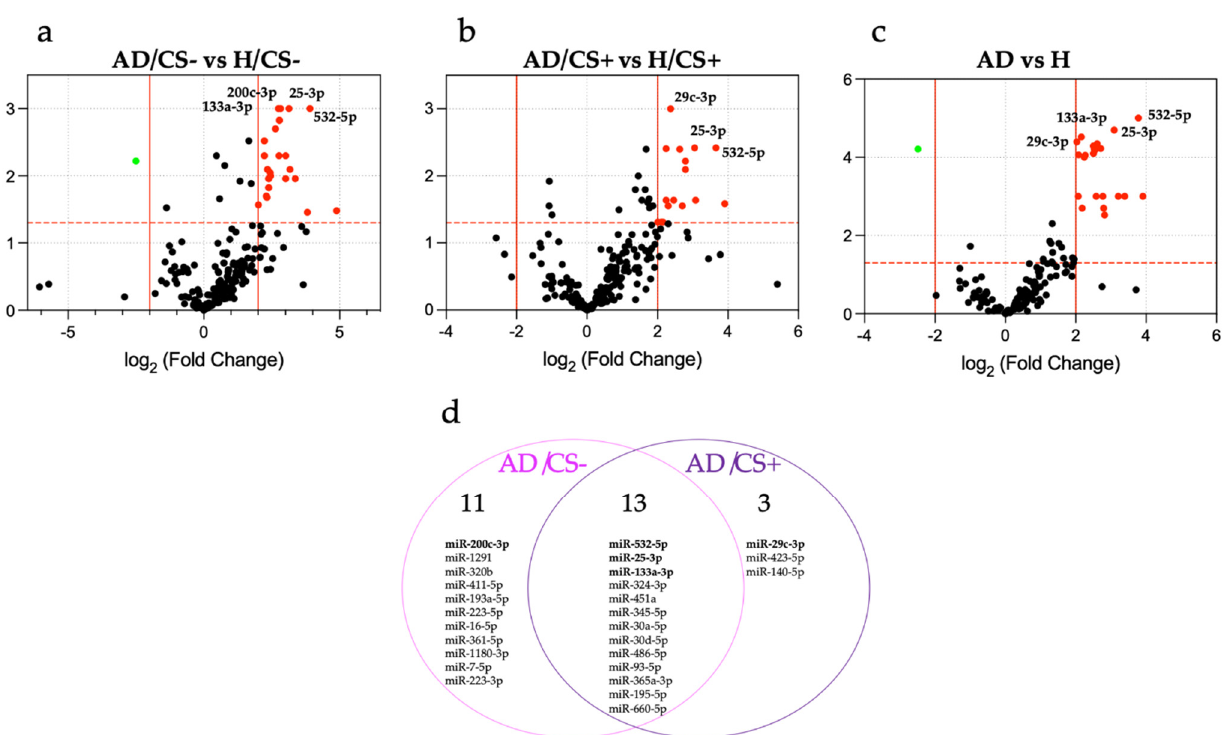
Figure 1. Analysis of the differentially expressed miRNAs in AD patients according to cigarette-smoking status, identified in the discovery phase. Volcano plots of the miRNA profiles ( a ) AD/CS − compared with H/CS − , ( b ) AD/CS+ compared with H/CS+, ( c ) AD compared with H. The red dots represent differential upregulation of miRNAs ( p < 0.05 and log2Fold Change > 2), and the green dots represent differential downregulation of miRNAs ( p < 0.05 and log2Fold Change < − 2). ( d ) Venn diagram analysis of the differentially expressed miRNAs in AD patients according to cigarette-smoking status. AD, adenocarcinoma; CS, cigarette smoking; H, healthy controls.